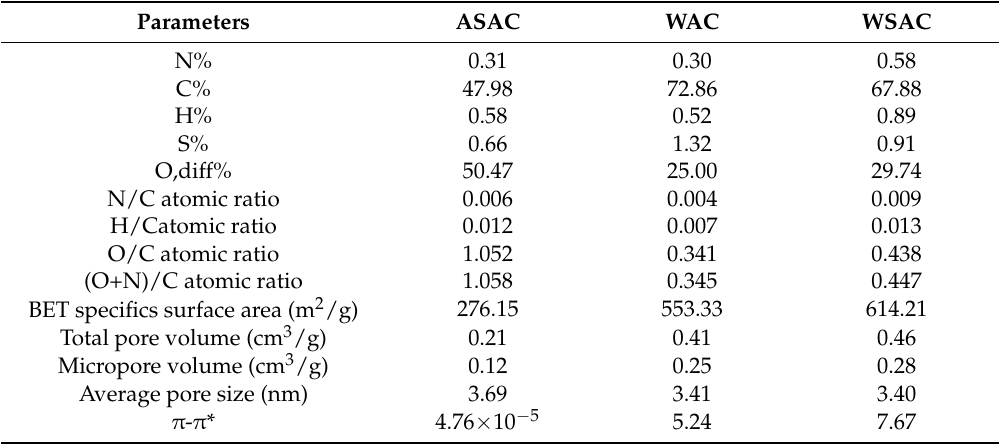
Table 1. Elemental composition and textural characteristics of the